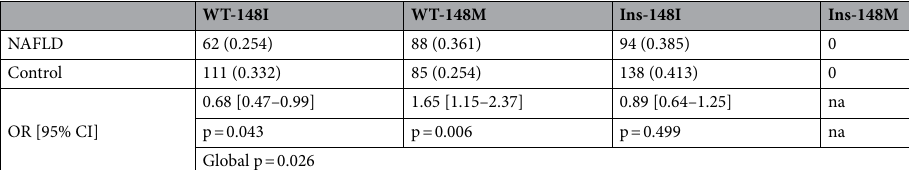
Table 2. Association of WT/Ins-I148M haplotype with NAFLD. WT-148I haplotype is protective, while WT-148M increases the risk of NAFLD. Both effects are attributable to the I148M variant itself, with no contribution of the WT/Ins variant. Number of subjects (haplotype frequencies) are shown. Results are expressed as OR [5–95%].